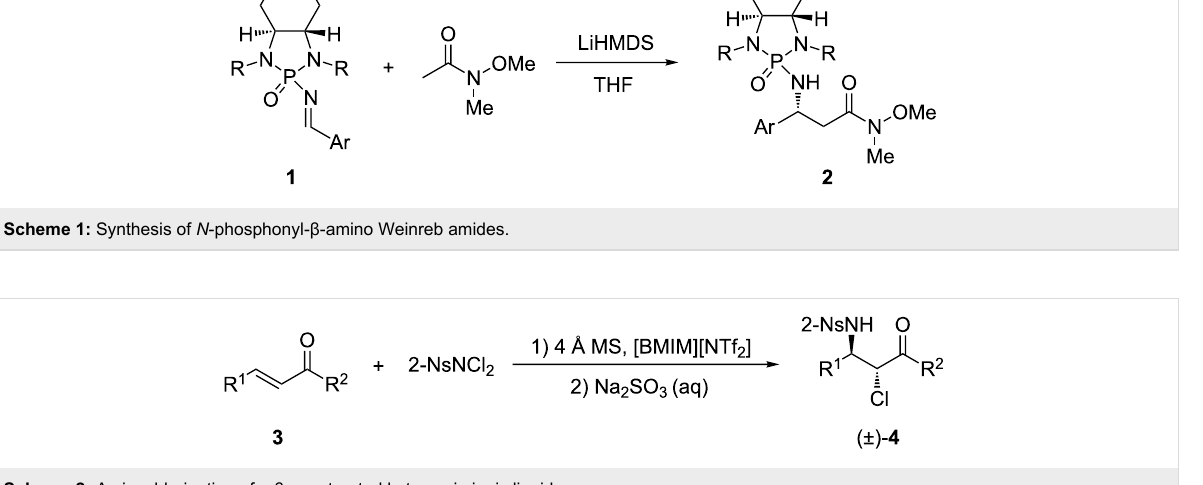
Scheme 2: Aminochlorination of α , β -unsaturated ketones in ionic